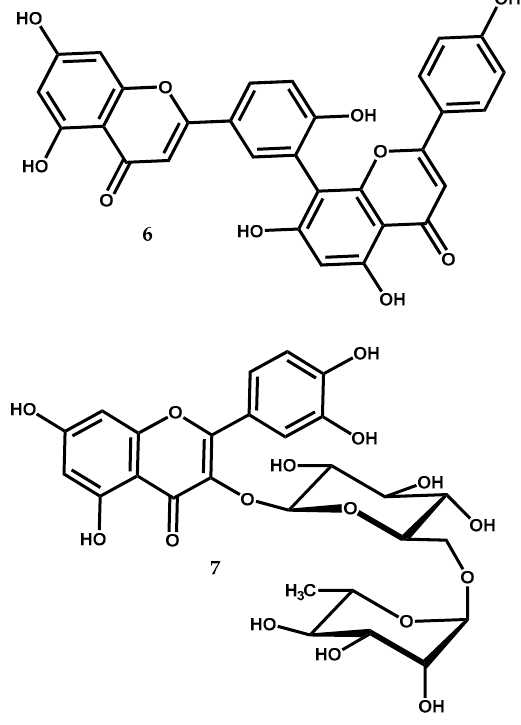
Figure 4. The bioactive flavonoids amentoflavone ( 6 ) and rutin ( 7 ) from Juniperus